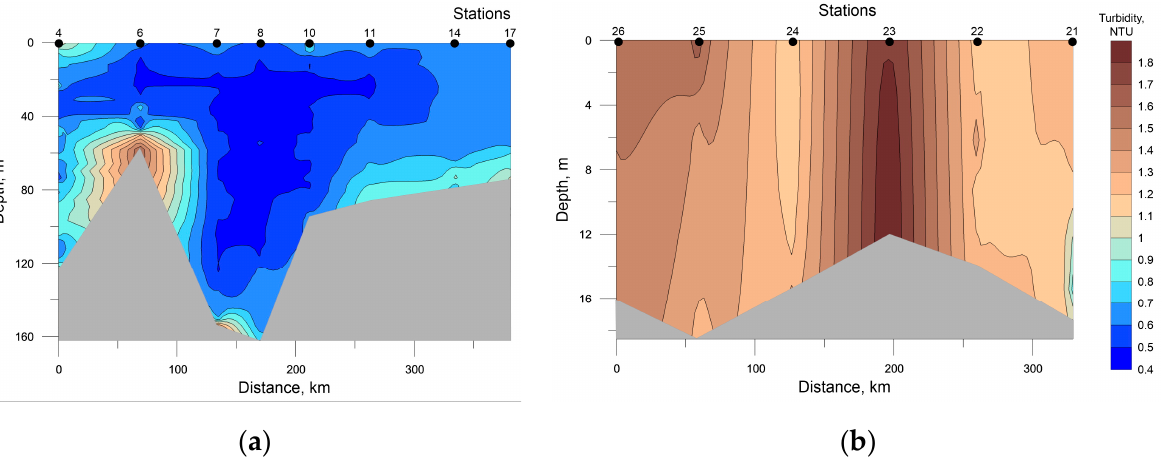
Figure 9. Distribution of seawater turbidity at the investigated transects in the southwestern Kara Sea ( a ) and the southeastern Barents Sea ( b ).